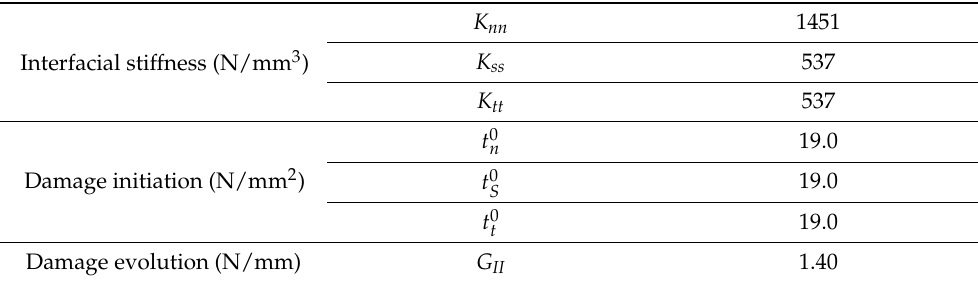
Figure 6. Schematic diagram of the boundary conditions of the pipeline model.